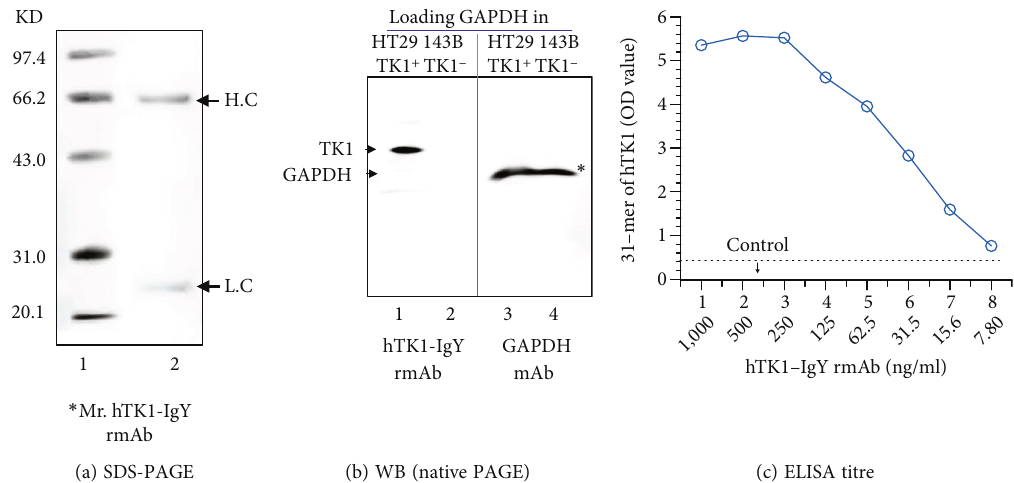
Figure 4: Speci fi city and sensitivity of hTK1-IgY-rmAb#5: (a) SDS-PAGE detection of the puri fi ed antibody (0.5 μ g). The IgY molecule heavy chain (H) was ≈ 66 kDa, and the light chain (L) was ≈ 25 kDa. (b) Western blot detection of antibody speci fi city; TK1-negative cell lines (143BTK1 - ) and TK1-positive cell lines (HT29) were used, and GAPDH was used as a loading control. (c) ELISA titre detected the #5 antibody. ∗ Mr.: molecular weight marker.